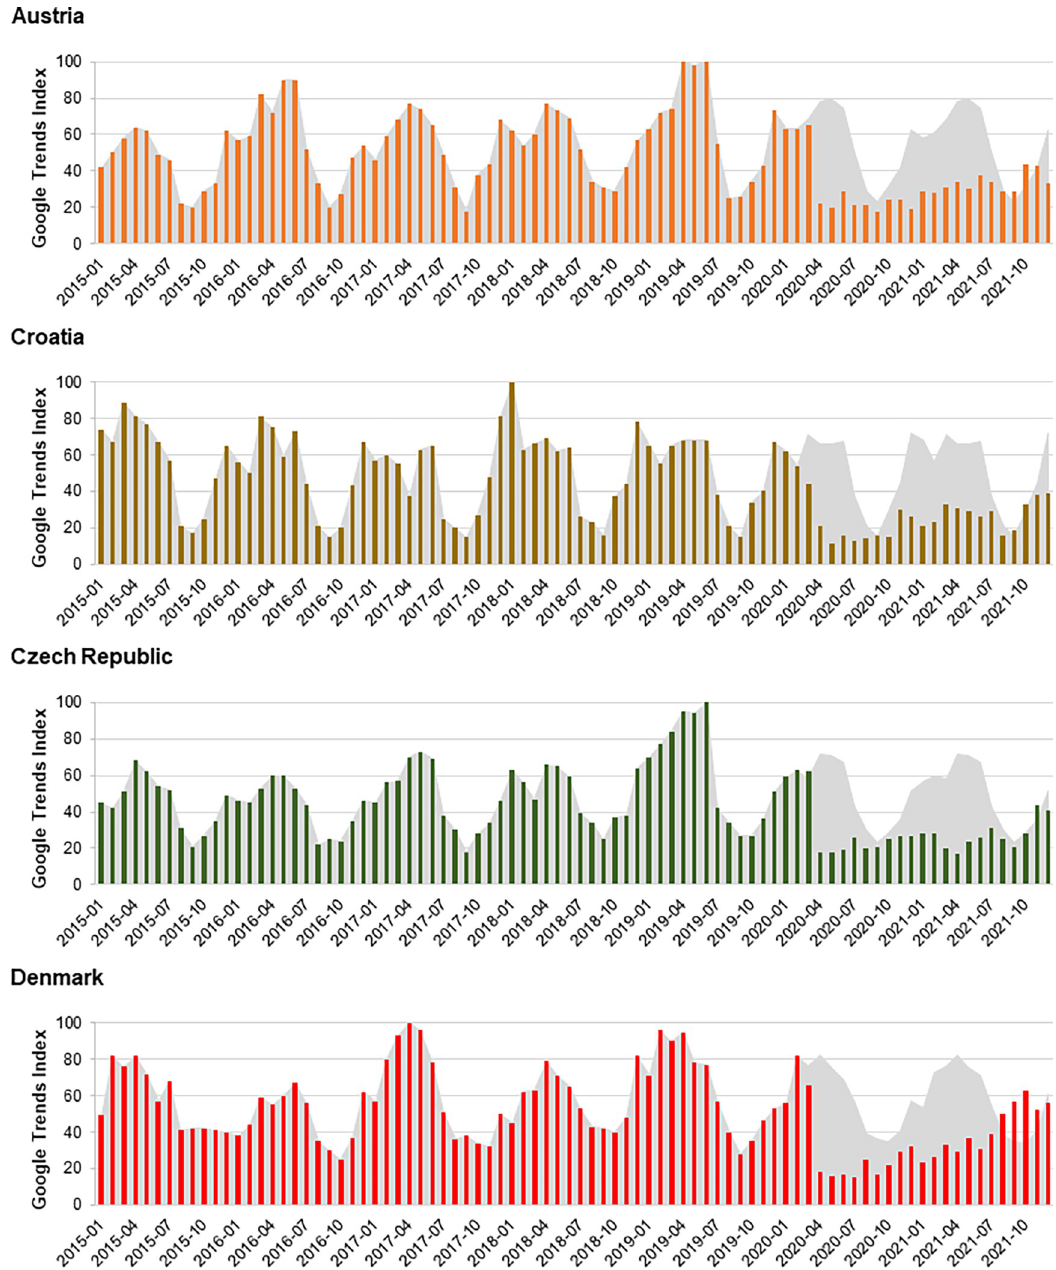
Fig 4. Monthly relative search query popularity of varicella keywords, 2015 to 2021, in four countries without UVV: Austria, Croatia, Czech Republic, and Denmark. The Google Trends Index reflects the relative search query popularity. The gray area shows the search query popularity predicted in the absence of COVID-19, estimated as the 5-year average of Google Index values observed in the same calendar month, from 2015 through 2019.